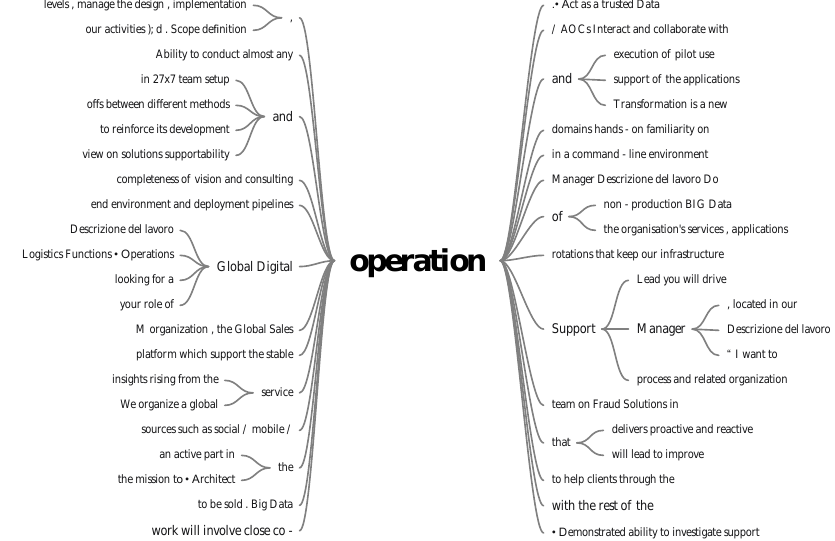
Figure 2: Example of a Word Tree Obtained Using ‘Operation’ as a Keyword for the